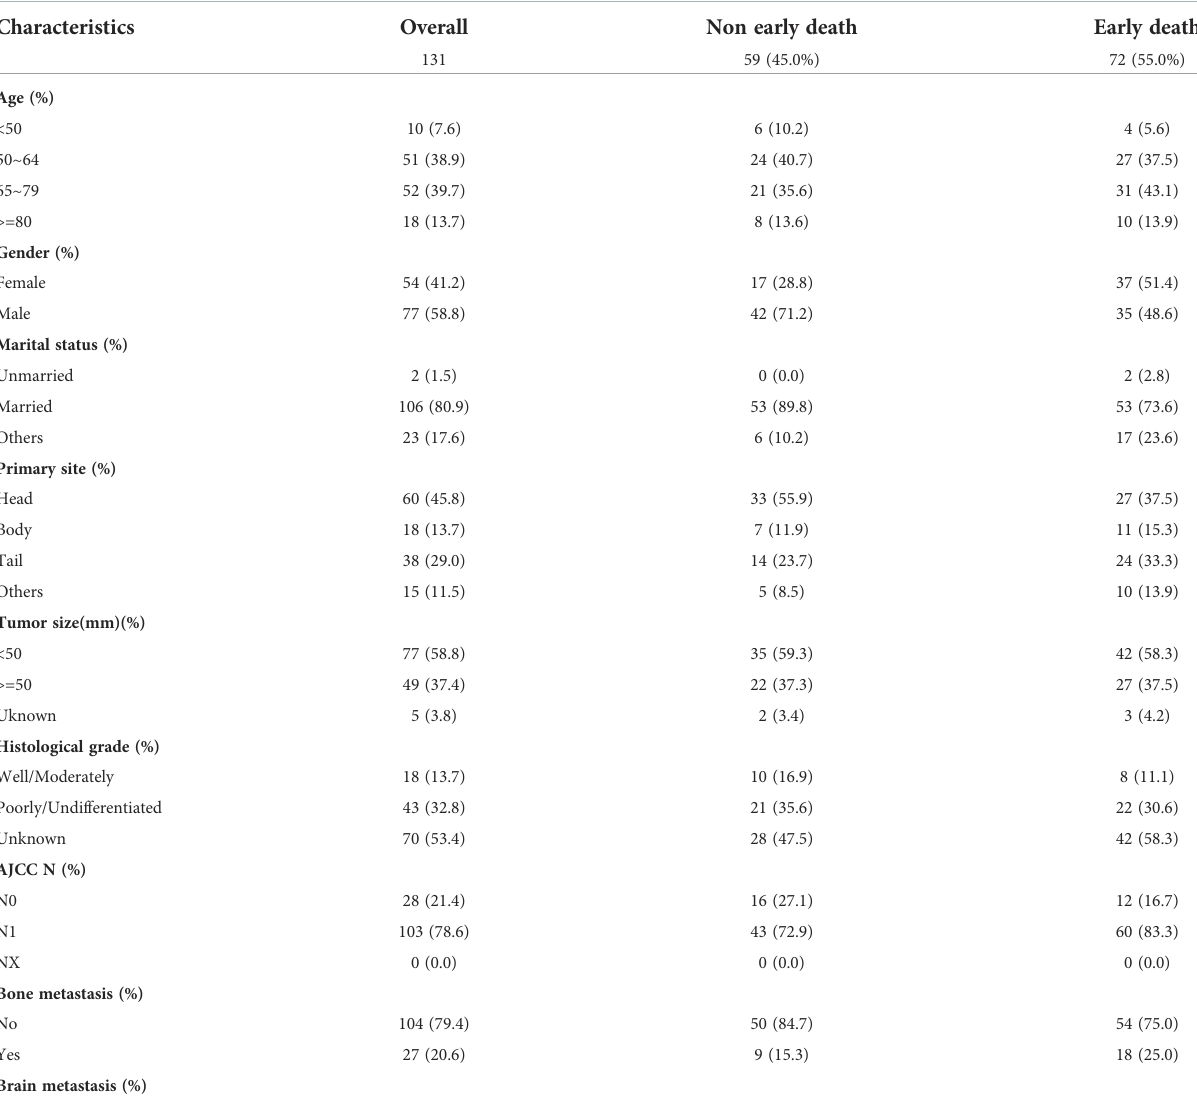
TABLE 2 Demographic and tumor characteristics of patients with PCLM in Chinese